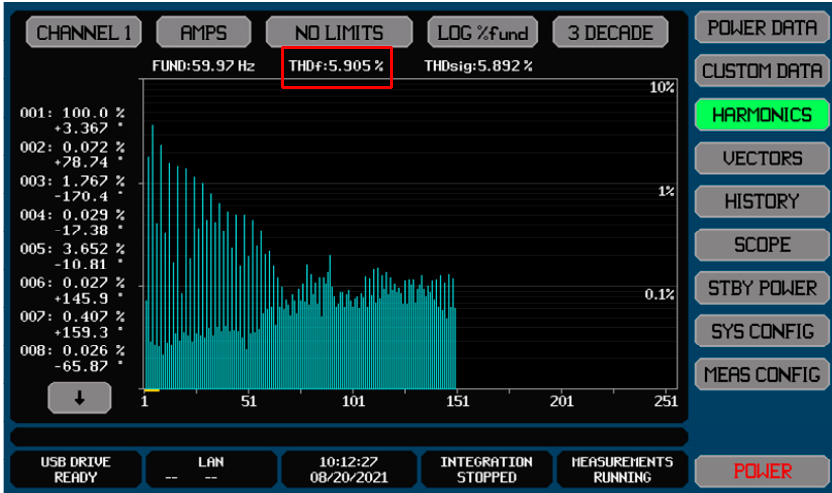
Figure 21. THD measured on the drive developed.